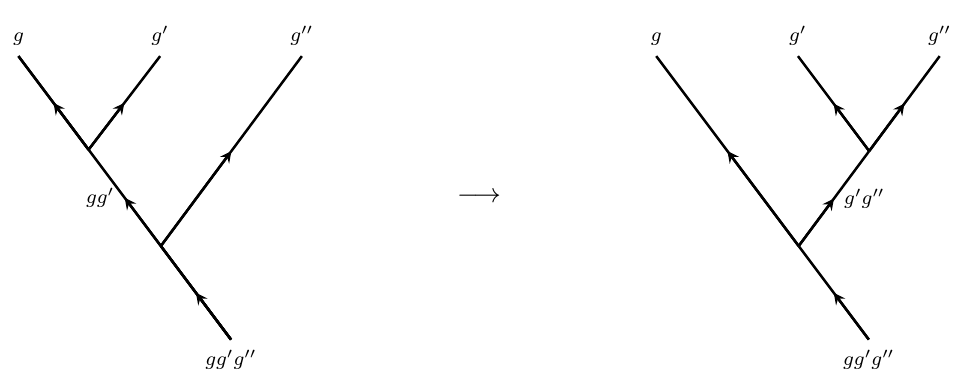
Figure 8 . The same background connection represented in two di(cid:11)erent ways as networks of topological line operators. If the symmetry is anomalous, they lead to di(cid:11)erent partition functions. that now it looks like the right hand side of (cid:12)gure 8. This changes the partition